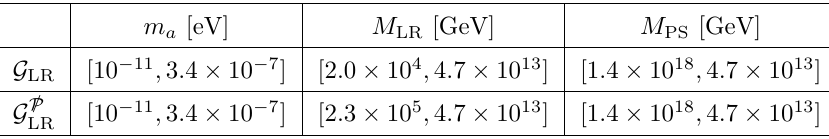
Table 3 . Mass windows from two-loop RG